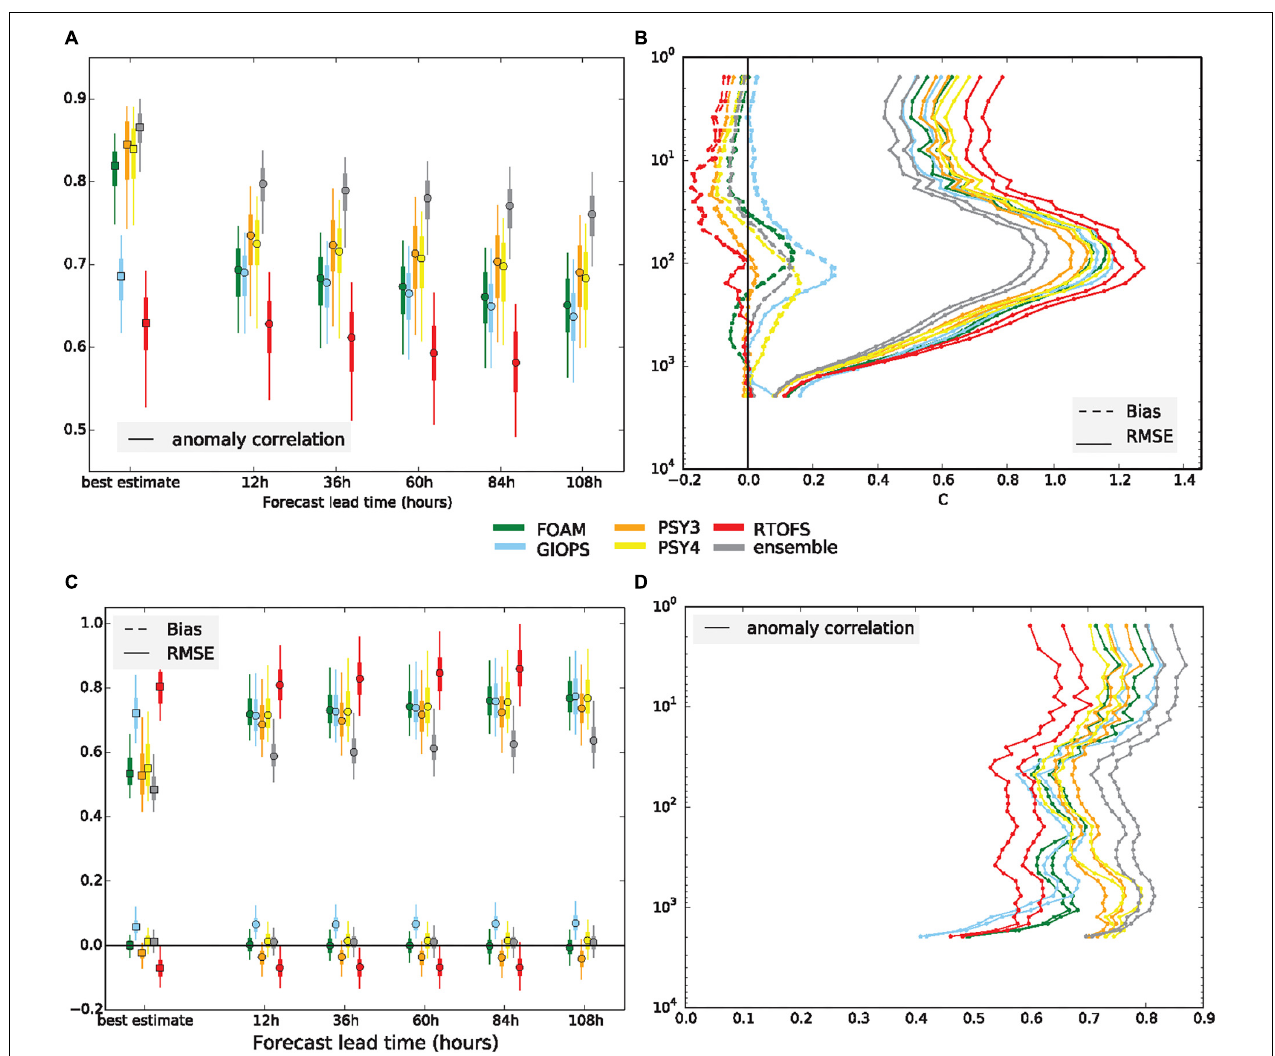
FIGURE 4 | Example of class 4 metrics from Ryan et al. (2015). Forecast accuracy against temperature measurements taken by Argo. (A) RMSE/bias as a function of forecast lead time. The boxes are the interquartile range and the 95th percentile. (B) RMSE/bias of 12 and 84 h forecasts as a function of depth, the vertical axis is logarithmic. (C) Similar to (A) with anomaly correlation as the metric. (D) Similar to (B) but with anomaly correlation as the